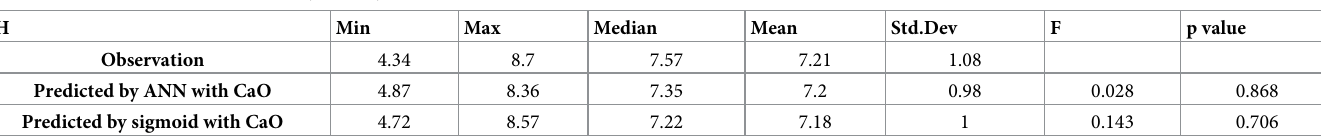
Table 7. Statistics of validation results (N =